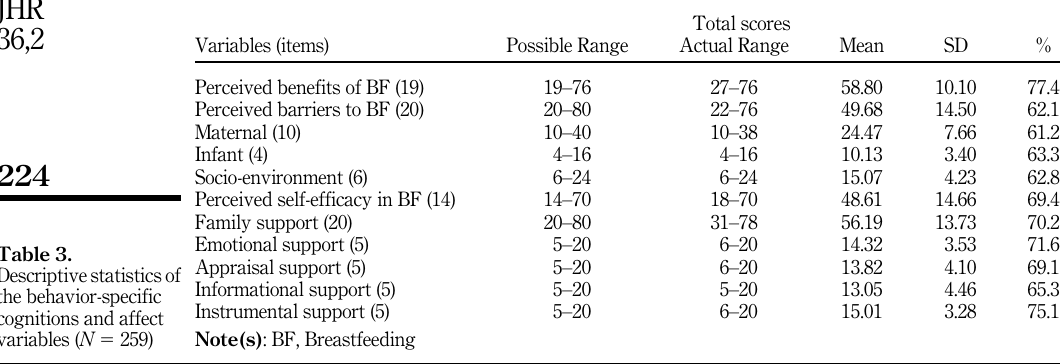
the behavior-specific cognitions and affect